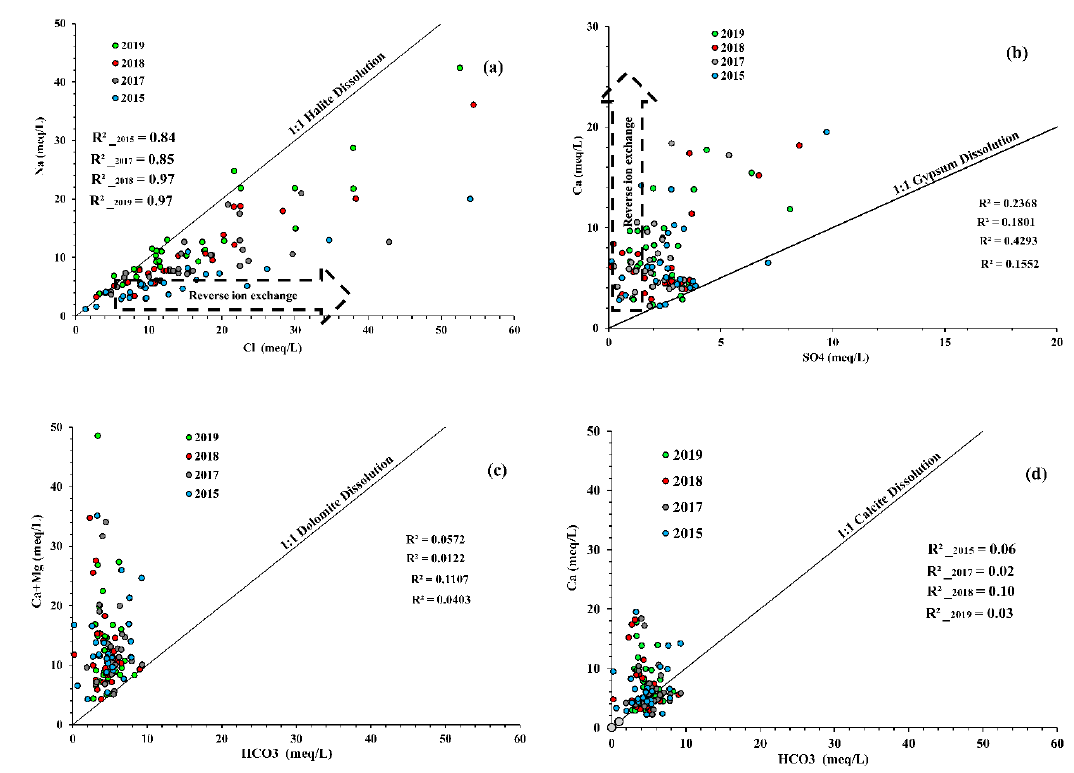
Figure 5. Correlation Diagrams: ( a ) Na vs. Cl, ( b ) Ca vs. SO 4 , ( c ) (Ca + Mg) vs. HCO 3 , ( d ) Ca vs. HCO 3 .